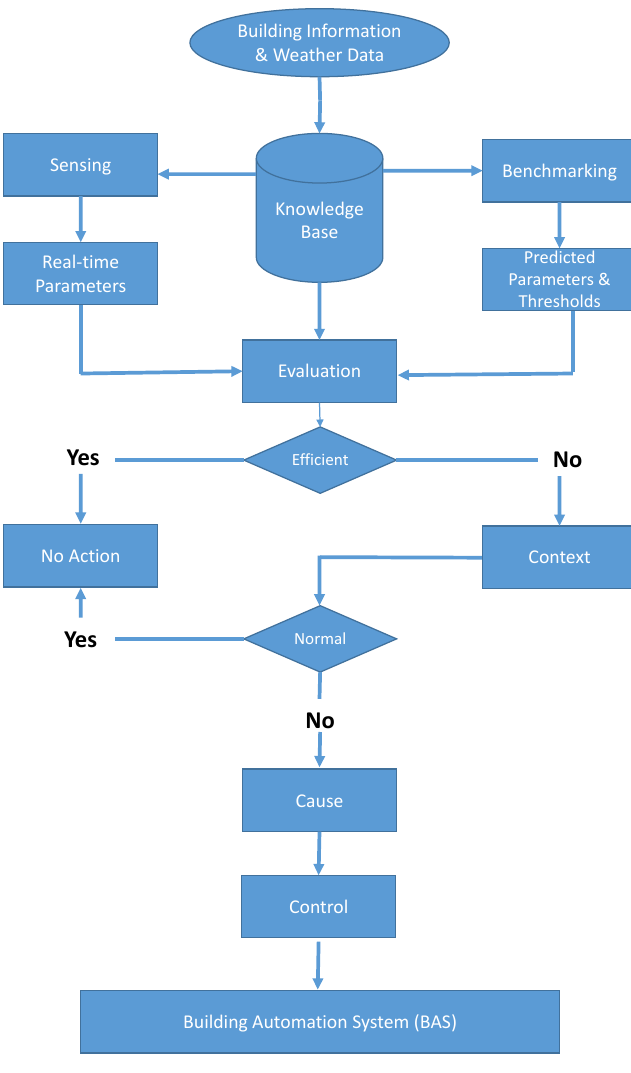
Figure 2. Process Flow